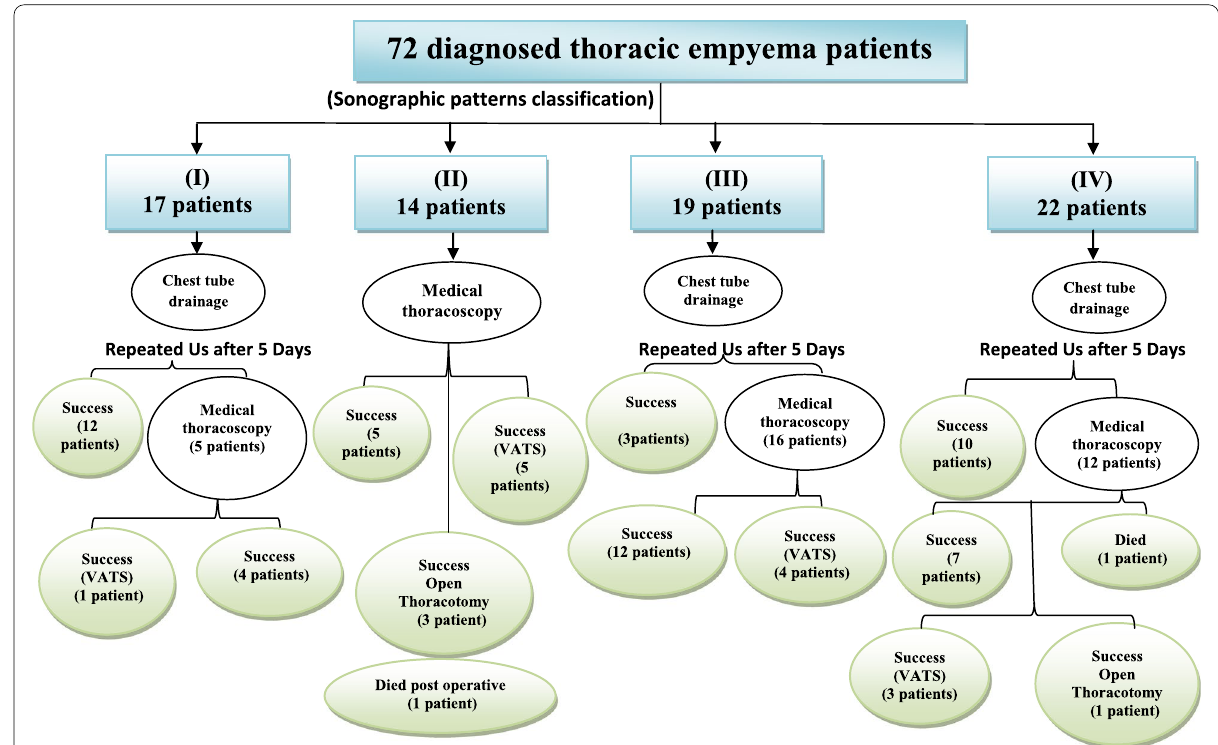
Fig. 1 The flow diagram showing the sonographic patterns of studied empyema patients and their final